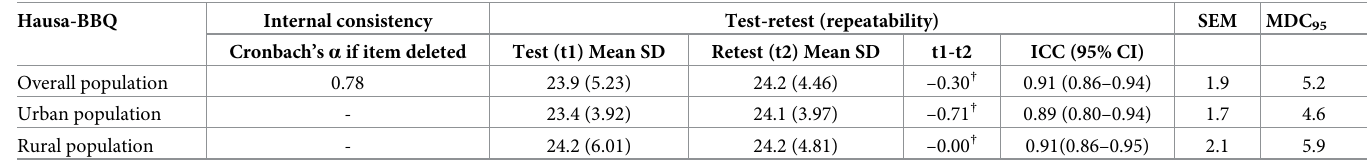
BBQ, Back Beliefs Questionnaire; ICC, intraclass correlation coefficient; CI, confidence interval; SEM, standard error of measurement; MDC, minimal detectable change. † p >